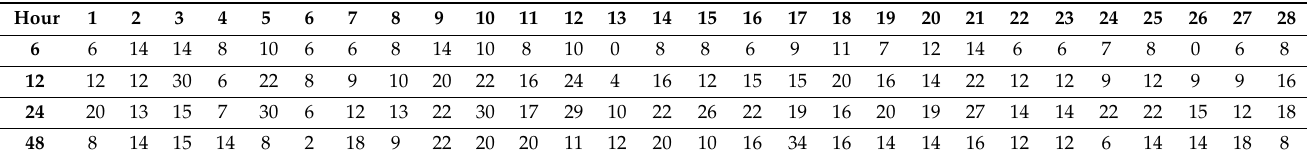
Figure 1. Evolution of IgG antibody titers against SARS-CoV-2 spike protein in individuals. Sera were obtained on days 0, 10, 20 (after first dose of vaccine) and 35 (2 weeks after second dose of vaccine). Skin DTH test was performed on day 36, 14 days after second dose, in all 28 individuals and showing 28/28 positive reactions. Mean diameter was 8.12 mm (STD 3.54) after 6 h of puncture, 14.43 mm (6.00) after 12 h, 18.29 mm (6.51) after 24 h and 14.18 mm (6.06) after 48 h of puncture (Table 1) (Figure 2a). Additionally, DTH cutaneous test had been performed on 11 participants at day 20, prior to the second dose. Results showed that 8 out of 11 individuals had a positive reaction (Figure 2b). Mean diameter of DTH skin test in the eight positive individuals was 3.2 mm after 6 h of puncture, 6.63 mm (5.26) after 12 h, 13.25 mm (4.71) after 24 h and 13 mm (8.39) after 48 h of puncture. No individual exhibits an immediate reaction after 15 min and up to 45 min after the IDT administration. Table 1. Diameter of DTH skin reaction in all 28 individuals at 6 h, 12 h, 24 h, and 48 h after intradermal test puncture according to the reports of the photographic impressions sent by the patients.